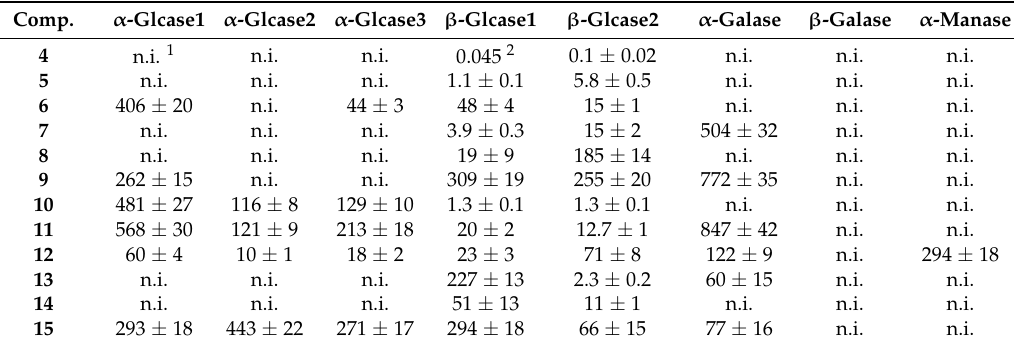
Table 1. Glycosidase inhibitory activities ( K i , µ M) of the new DNJ and DIJ isothiourea ( 4 – 9 ) and thiourea ( 10 – 15 ) derivatives. Values represent the mean ± SD (three independent determinations). Inhibition was competitive in all the cases.